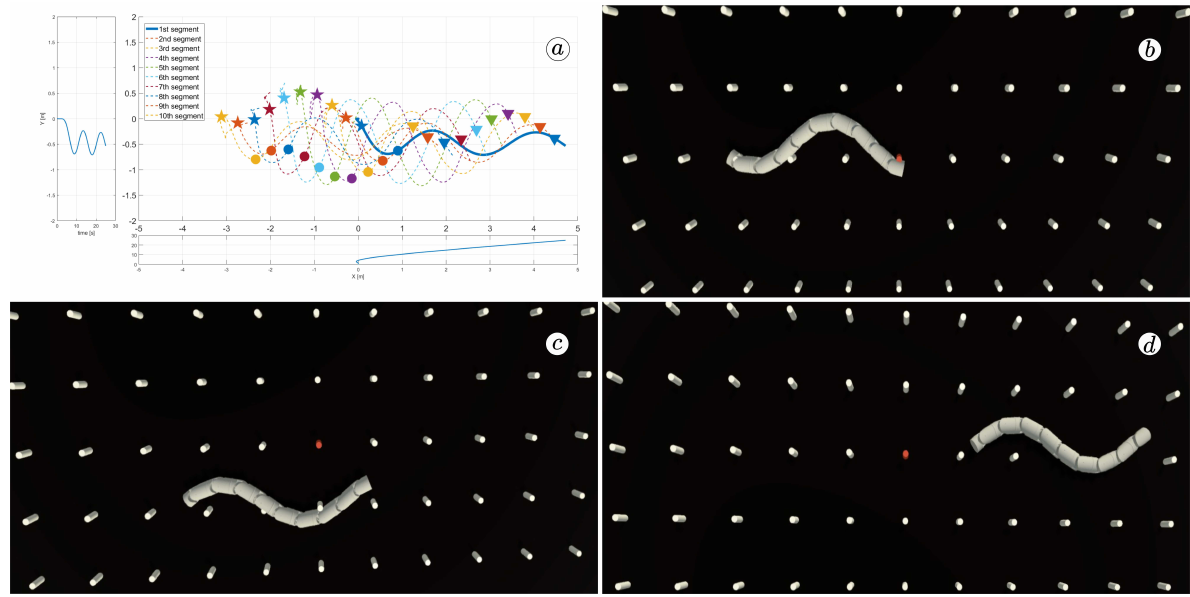
Figure 8. Trajectories of robot segments for c t = 0.1 and c n = 10 ( a ) and robot configurations for t = 5 ( s ) ( b ), t = 10 ( s ) ( c ), and t = 24 ( s ) ( d